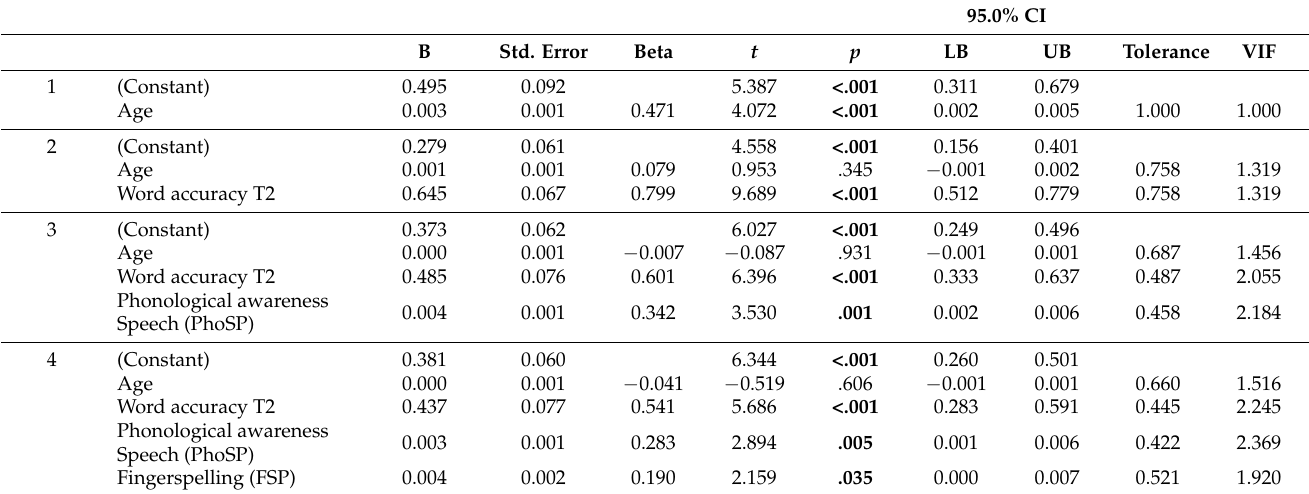
Table 6. Regression coefficients for word accuracy at T3. Significant predictors are bolded.